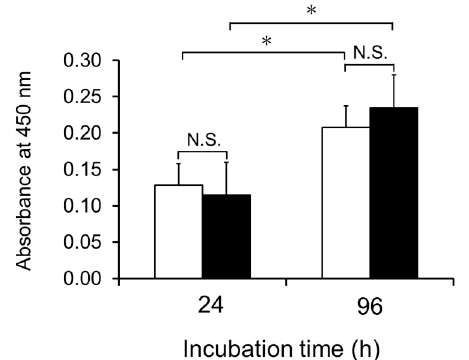
Figure 1. Effect of a mixture of Pro-Hyp and Hyp-Gly on the growth of fibroblasts on collagen gel in the presence of 10% FBS-1; ( □ ), control; ( ■ ), medium containing Pro-Hyp and Hyp-Gly at 100 µM, respectively. Data are shown as mean ± standard deviation (SD) ( n = 5). Asterisks indicate significant di ff erences ( p < 0.05; Tukey’s test). N.S. indicates results that are not significantly di ff